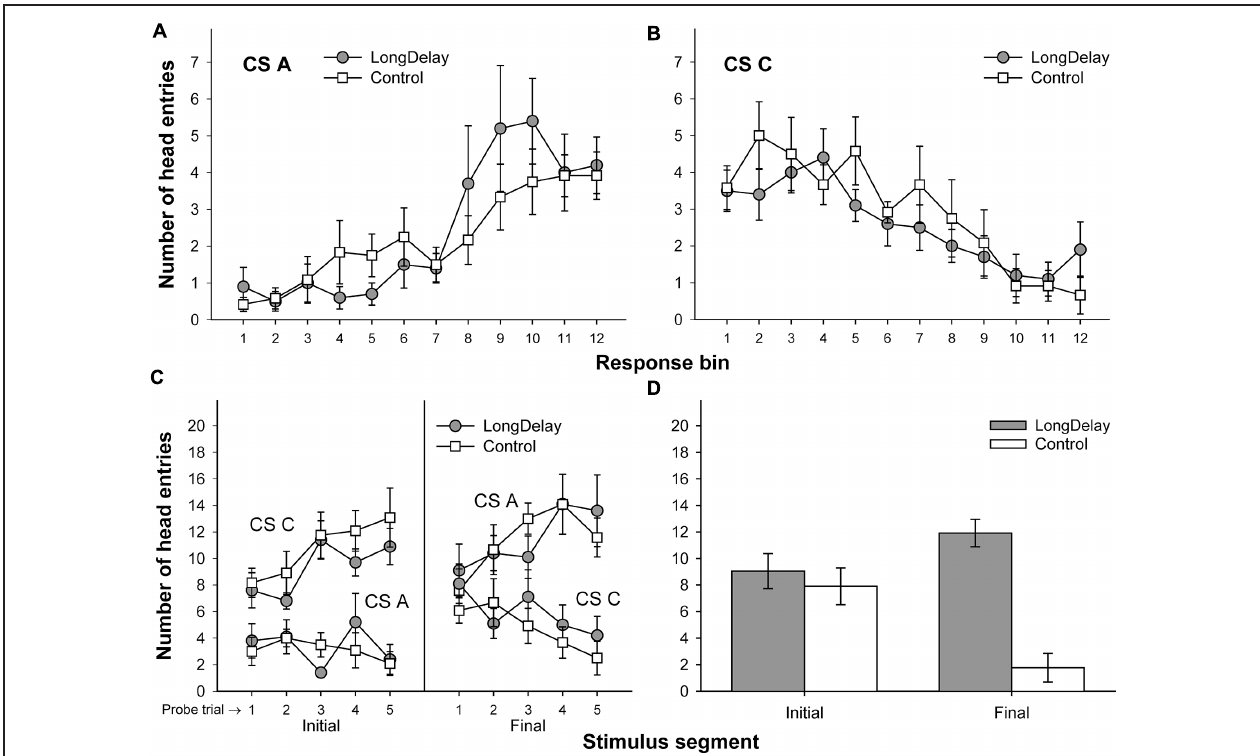
FIGURE 4 | Results of Experiment 1b. The top panels represent responding to CSs A (A) and C (B) during each of the 12 5-s bins of the last probe trial of long delay conditioning training. US delivery was expected at 55 s (Bin 11) or 10 s (Bin 2) after onset of CSs A and C, respectively. (C) Presents responding to the initial (average of Bins 1–3) and final (average of Bins 10–12) segments of CSs A and C during the five probe trials of long delay conditioning training. (D) Presents responding to the initial and final segments of test compounds AC (Group LongDelay) and BC (Group Control) during the two summation test trials (averaged). Brackets represent the standard error of the